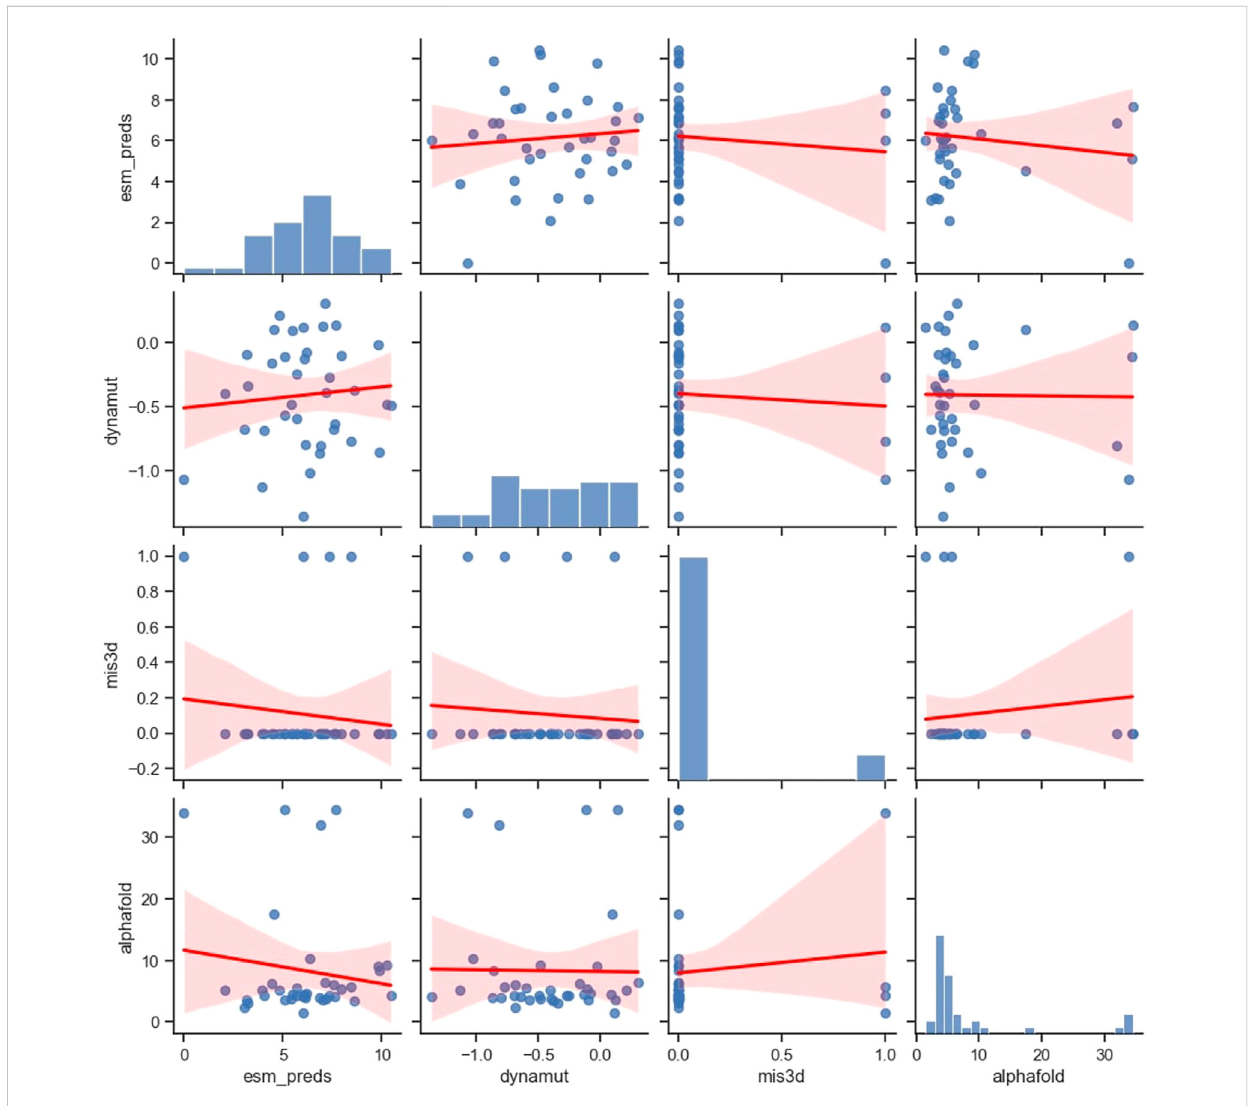
FIGURE 4 Pairwise correlation of the variants between the four in silico predictors.